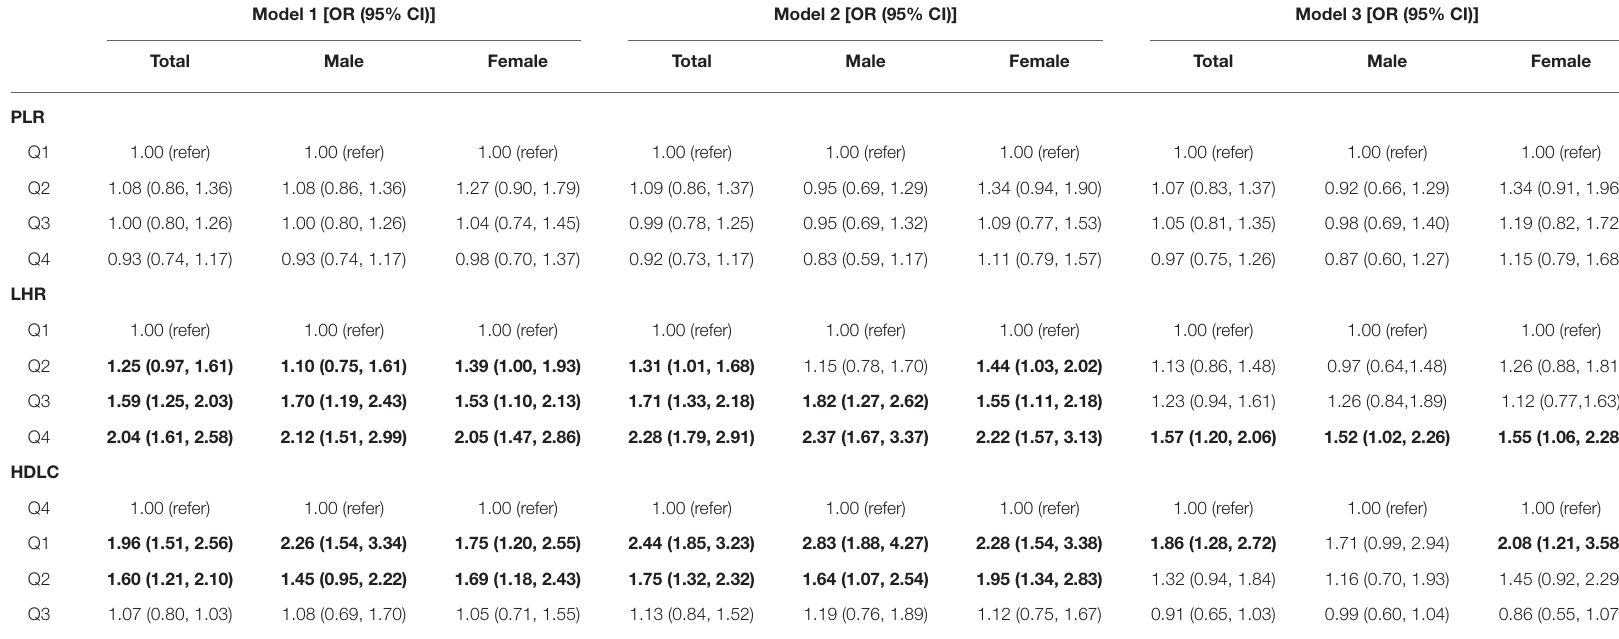
TABLE 4 | Binomial logistic regression analysis showing independent predictors of newly diagnosed